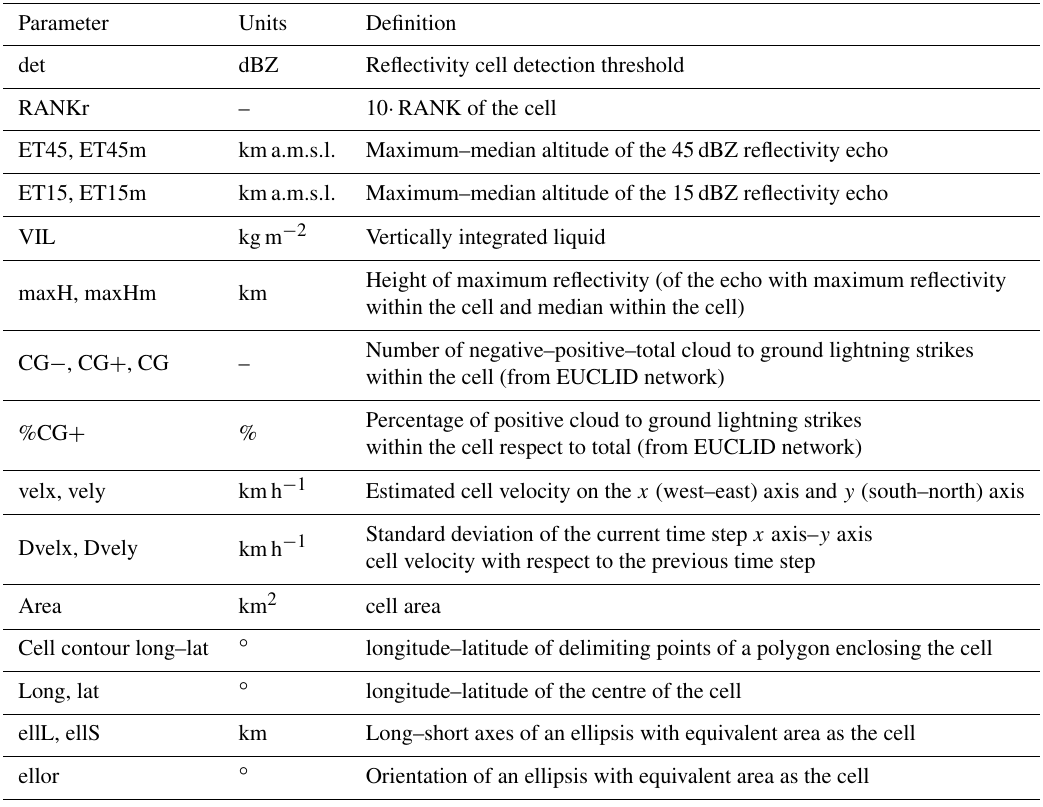
Table 1. TRT cell parameters computed operationally.